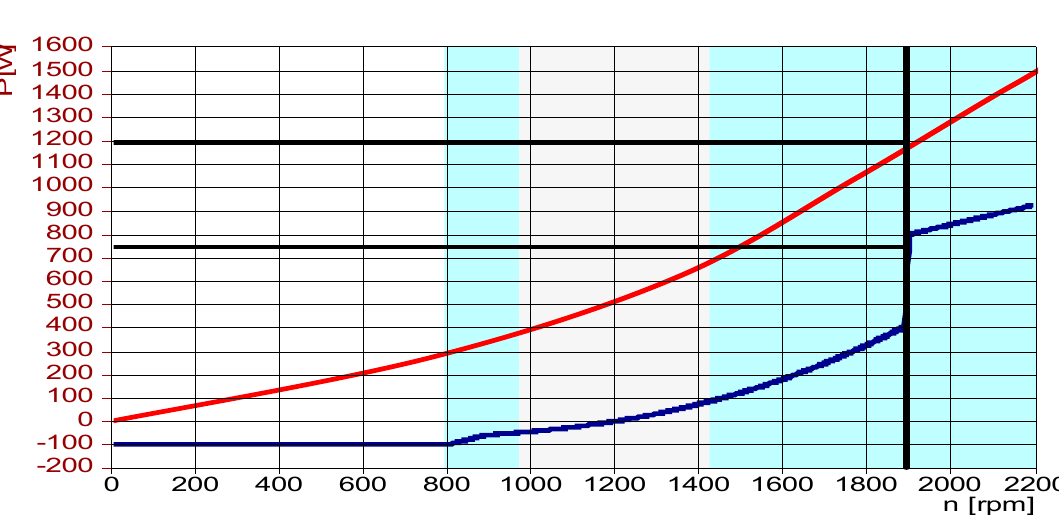
Figure 14. Wind speed based on DFIG with a speed of 10.5 m/s. Figure 15 illustrates the figures obtained when speed = 8.5 m/s . Total power ((cid:1842) (cid:3047)(cid:3042)(cid:3047) ) = 212 W , mechanical power ((cid:1842) (cid:3040)(cid:3032)(cid:3030) ) = 530 W as shown by the first horizontal black line, rotation speed (cid:1840) = 1667 r. p. m. is shown by the grid vertical black line and voltage sag = 40% of the voltage line to line ( (cid:1848) ((cid:3013)(cid:2879)(cid:3013)) ). Active power at the line side converter is equal to ((cid:1842) (cid:3039)(cid:3046) ) = −62 W , whilst power generated by the wind was 274 W, as shown by the second horizontal black line. The inertia moment was (cid:1839)((cid:1840)(cid:1865)) = 3 .